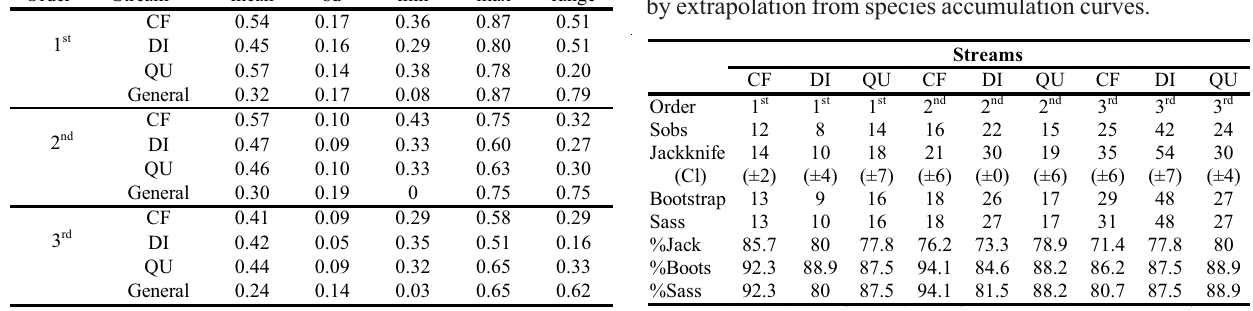
Table 4. Species richness in 100-m segments of 1 st , 2 nd , and 3 rd order streams, estimated by the methods of Jackknife 1, Boot- strap and by extrapolation from species accumulation curves. Cl= confidence limits of methods of Jackknife 1; Sobs= observed richness; Sass= richness estimated by extrapolation from spe- cies accumulation curves; %Jack= percent of observed spe- cies richness in relation to that estimated by the Jackknife method; %Boots= percent of observed species richness in re- lation to that estimated by the Bootstrap method; %Sass= per- cent of observed species richness in relation to that estimated by extrapolation from species accumulation curves.